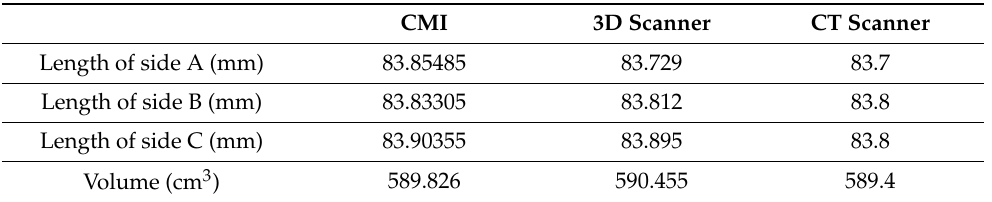
Table 7. Comparison of the measurement accuracy of both technologies on a reference object cali- brated by the CMI (Czech Metrology Institute).